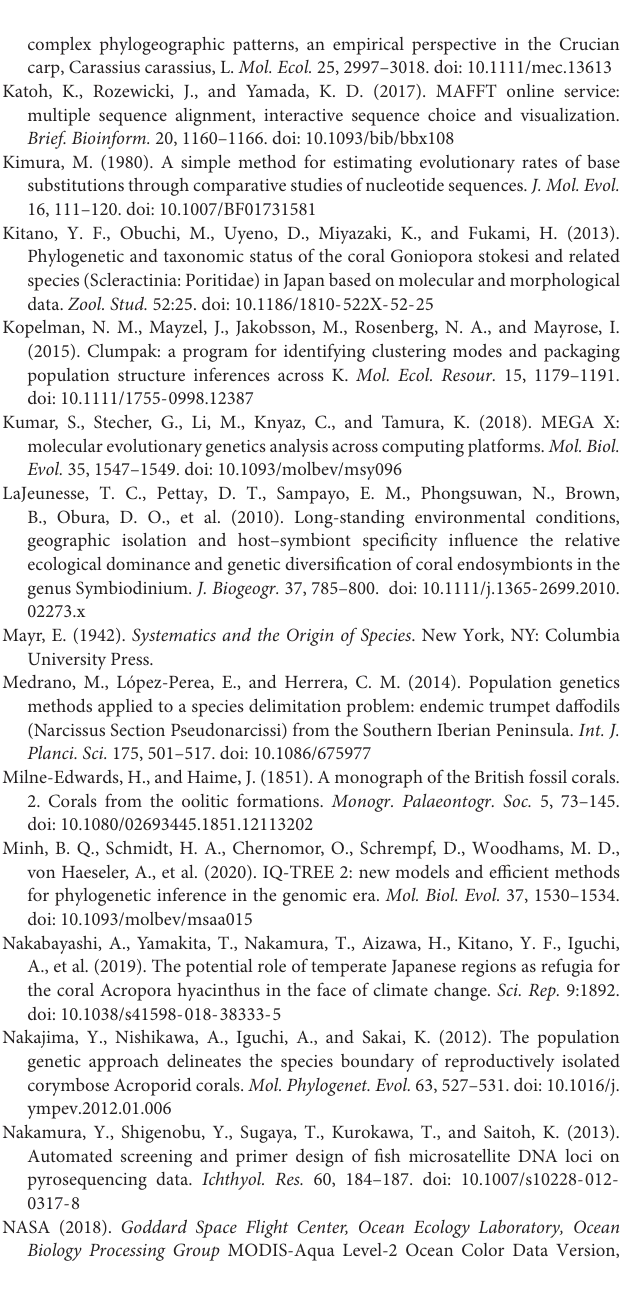
Supplementary Table 1 | Morphological data of samples used for STRUCTURE analyses. Supplementary Table 2 | Microsatellite dataset used in this study in GenAlEx format. Supplementary Table 3 | Delta K calculations for STRUCTURE analysis. Supplementary Table 4 | Environmental parameters of different